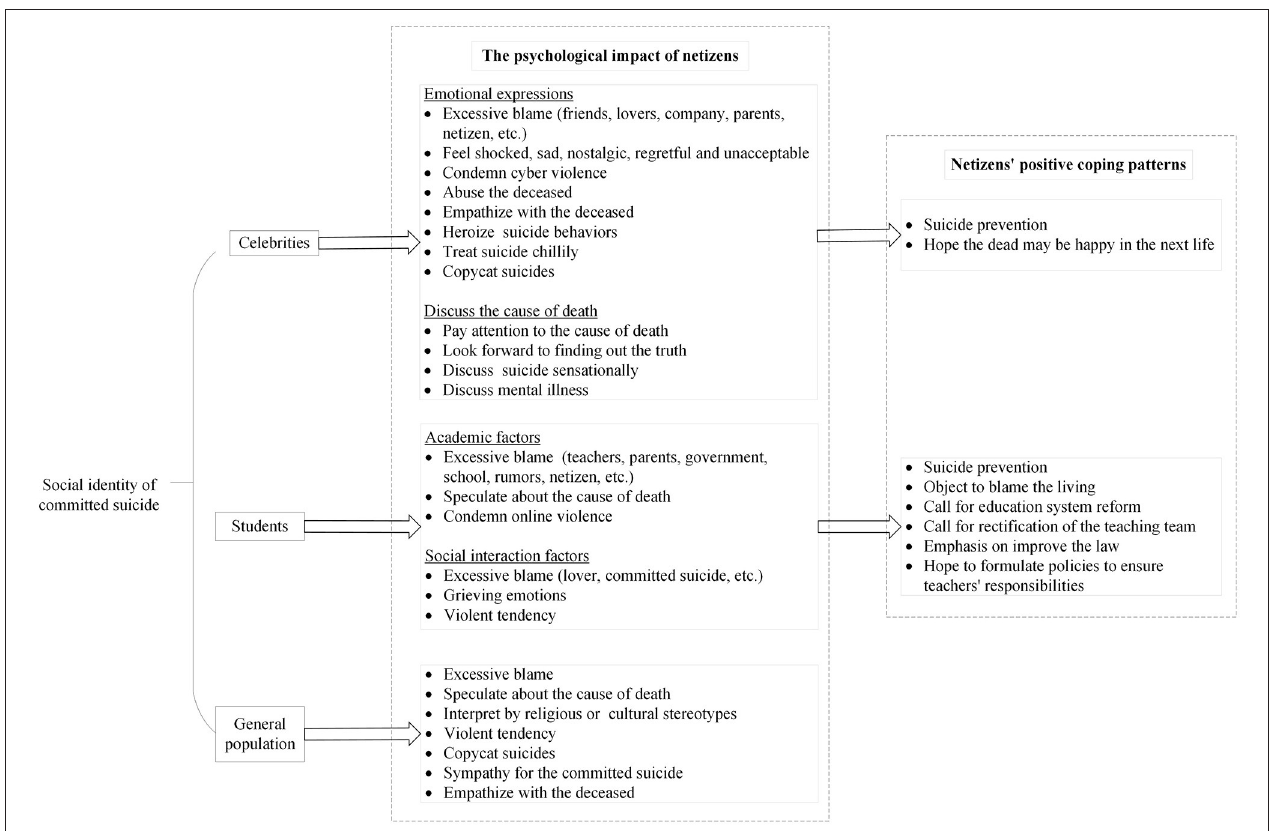
FIGURE 3 | The effect of high EII suicide-related news on public opinion and response patterns of netizens by different social identities (n 3 = 2,654 Weibo comments).